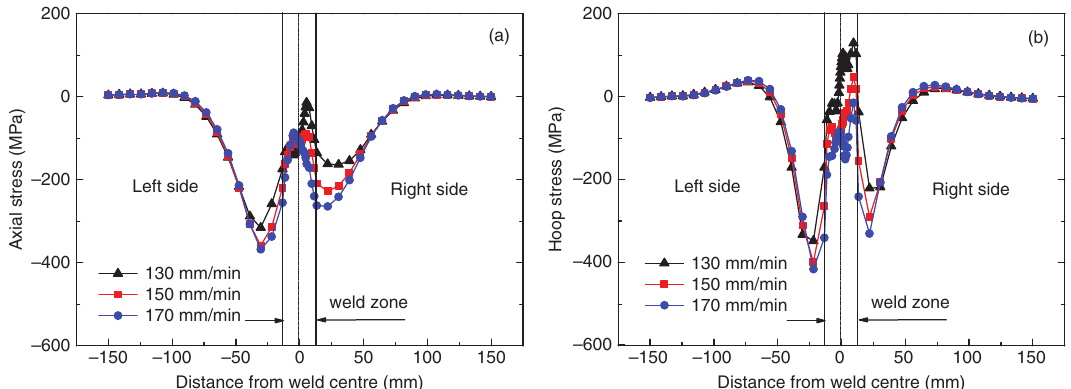
Figure 6: Residual stresses distributions at different arc travelling speeds along path 1: axial stress (a), hoop stress